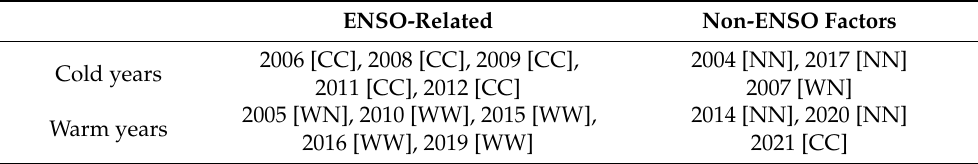
Table 1. The ICP cold and warm years and the corresponding seasonal ENSO conditions as revealed by the preceding winter and spring ONI. The cold, warm, and neutral conditions are denoted as characters C, W, and N, respectively, in the square brackets. The first (second) character is for winter (spring) ONI. Note that only seven cold years can be identified after the year 2003; the year 2004, with an anomalous value of − 0.34, was selected to be a cold year to ensure the same sample size for the warm-year and cold-year